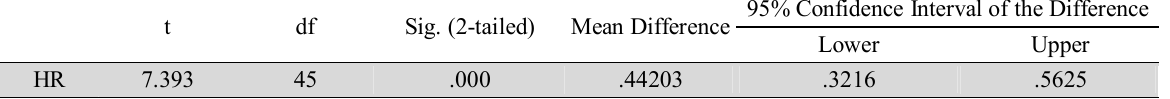
The summary of testing the effect of information technology on human resources (Test value = 3)